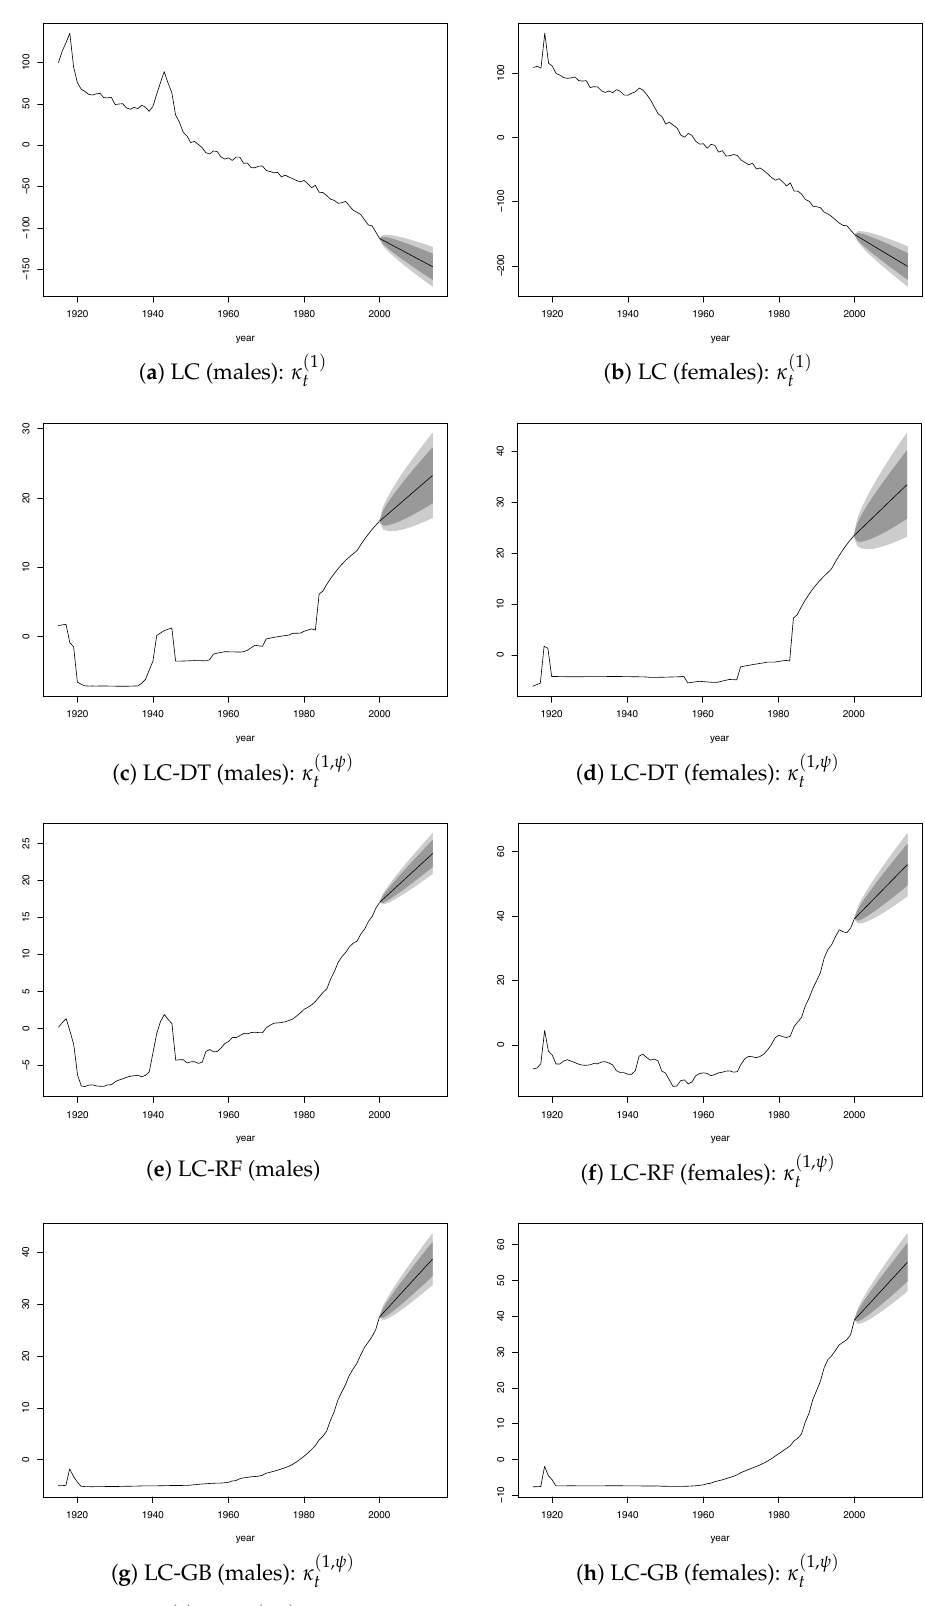
( 1, ψ ) ( 1 ) and κ : Fitted value (1915–2000) and forecasted values t t